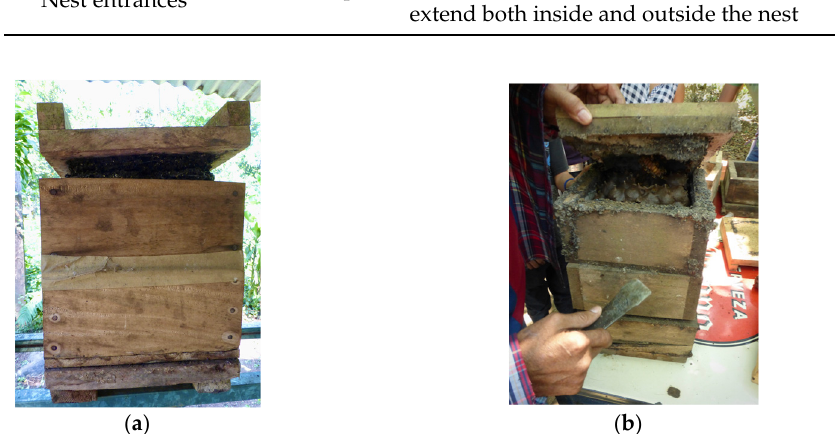
Figure 2. ( a ) Even in wooden box hives, many colonies seal cracks with a thick layer of propolis. ( b ) To access these colonies, beekeepers often use a hive tool to pry the lid from the hive body; excess propolis is sometimes lost in this